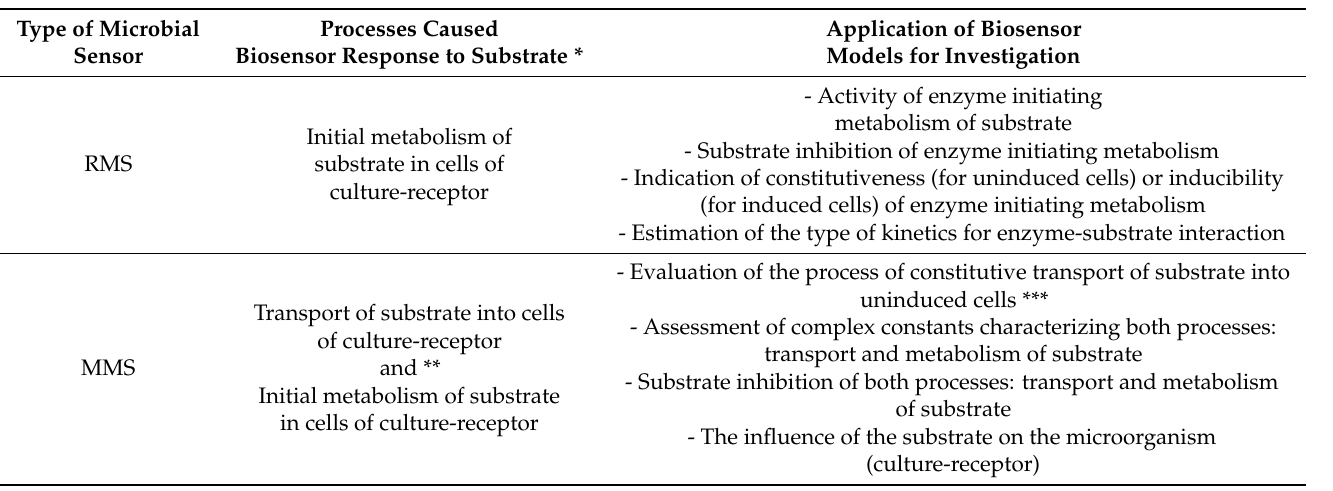
Table 1. The use of laboratory models of respiratory electrochemical microbial sensors for biochemi- cal